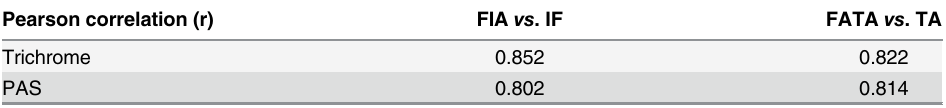
P < 0.0001 for all pairwise correlations. n = 77 – 79. FIA, fractional interstitial area; IF, interstitial fi brosis; FATA, fractional atrophic tubular area; TA, tubular